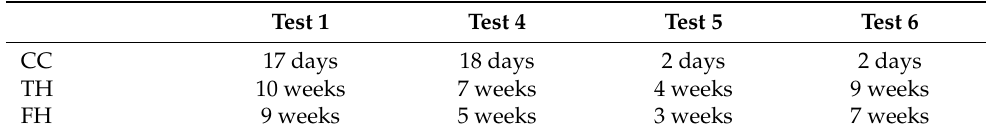
Table 6. Stabilization times for tests 1, 4, 5 and 6 for CC, TH and FH.